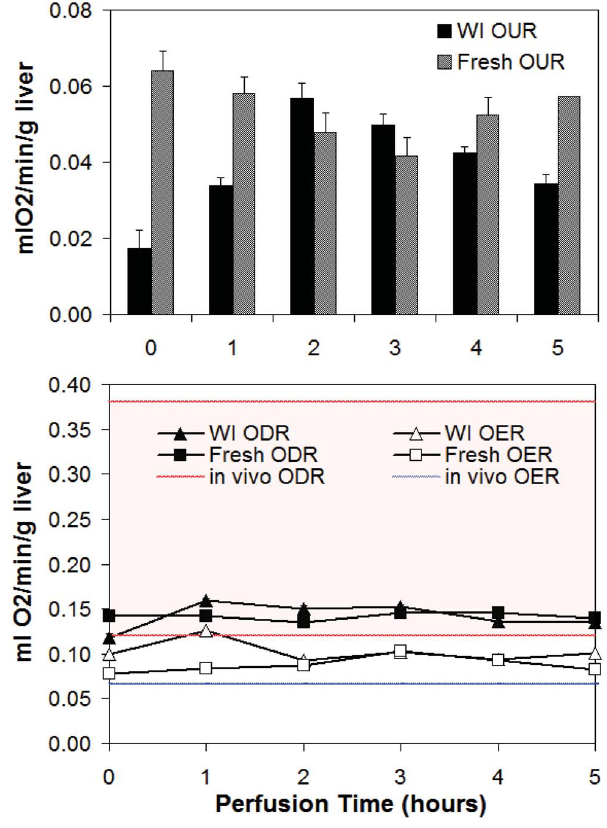
Figure 1. Oxygen trends in Fresh and WI livers. A) Oxygen uptake rate (OUR) for WI and Fresh livers. B) Oxygen delivery rate (ODR) and exit rate (OER) in perfused livers compared to those in vivo . Red and blue lines represent the range in ODR and OER (average + / 2 1std dev); the range for OER is negligible.